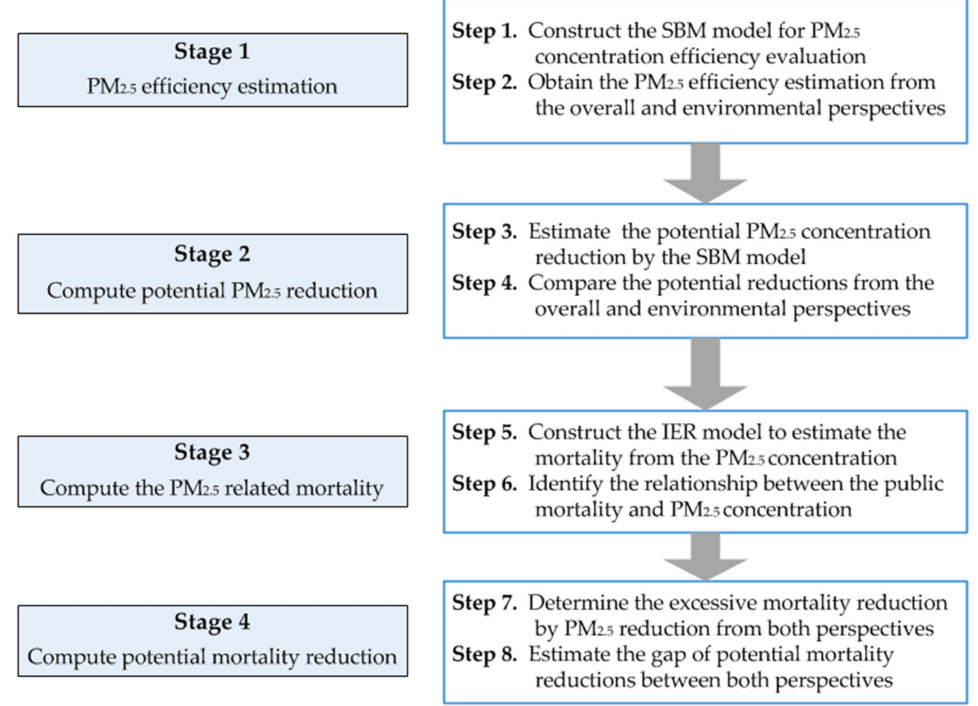
Figure 2. Flowchart of the proposed